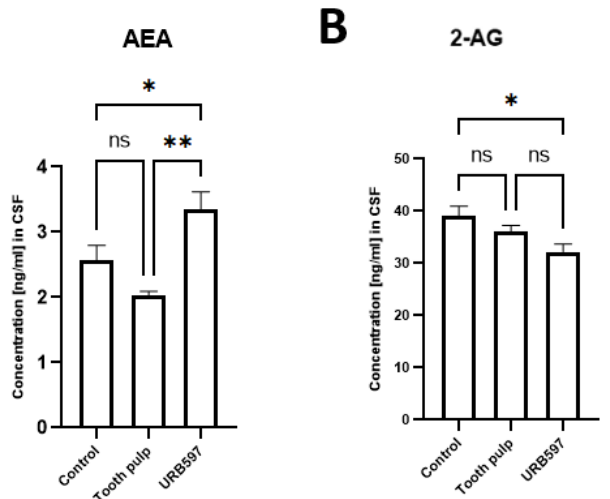
Figure 1. Comparison of the ( A ) AEA and ( B ) 2-AG concentrations in the CSF in controls and after tooth pulp and URB597 treatment. The data represent the mean ± SEM of 6 rats per group. Statistical significance was assessed using one-way ANOVA and a post hoc multiple-comparison Tukey